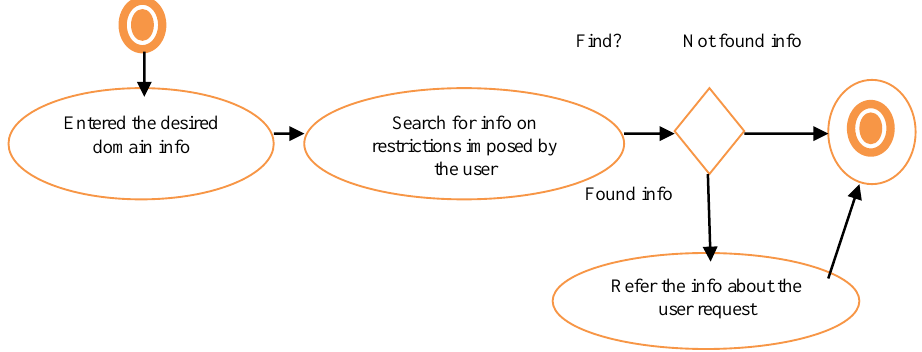
Figure 11. Search capability